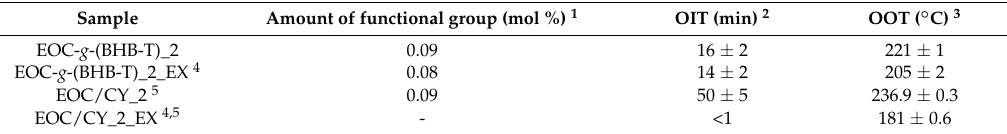
Table 5. OIT and OOT values after migration test.